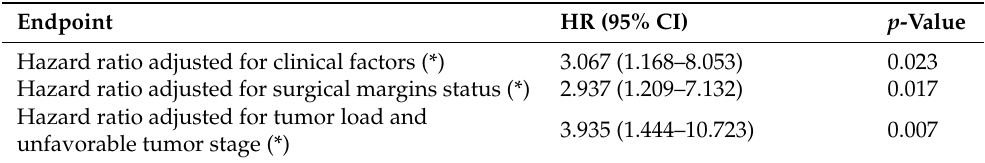
Figure 1. Risk curves depicting time to disease relapse stratified by no tumor upgrading/favorable tumor upgrading (ISUP ≤ 2) vs. unfavorable tumor upgrading (ISUP > 2) in 237 low-risk prostate cancer patients classified according to the European Association of Urology system, treated with robot-assisted radical prostatectomy, with a median follow up of 53 months. On univariable analysis (Cox’s proportional hazards), unfavorable tumor upgrading was a prognostic factor for PCa relapse (hazard ratio, HR: 3.352; 95% CI: 1.393–8.067; p = 0.007). Table 2. Multivariable Cox regression models testing the independent predictor status of unfavorable tumor upgrading (ISUP > 2) on disease relapse in 237 low-risk prostate cancer patients treated with robot-assisted radical